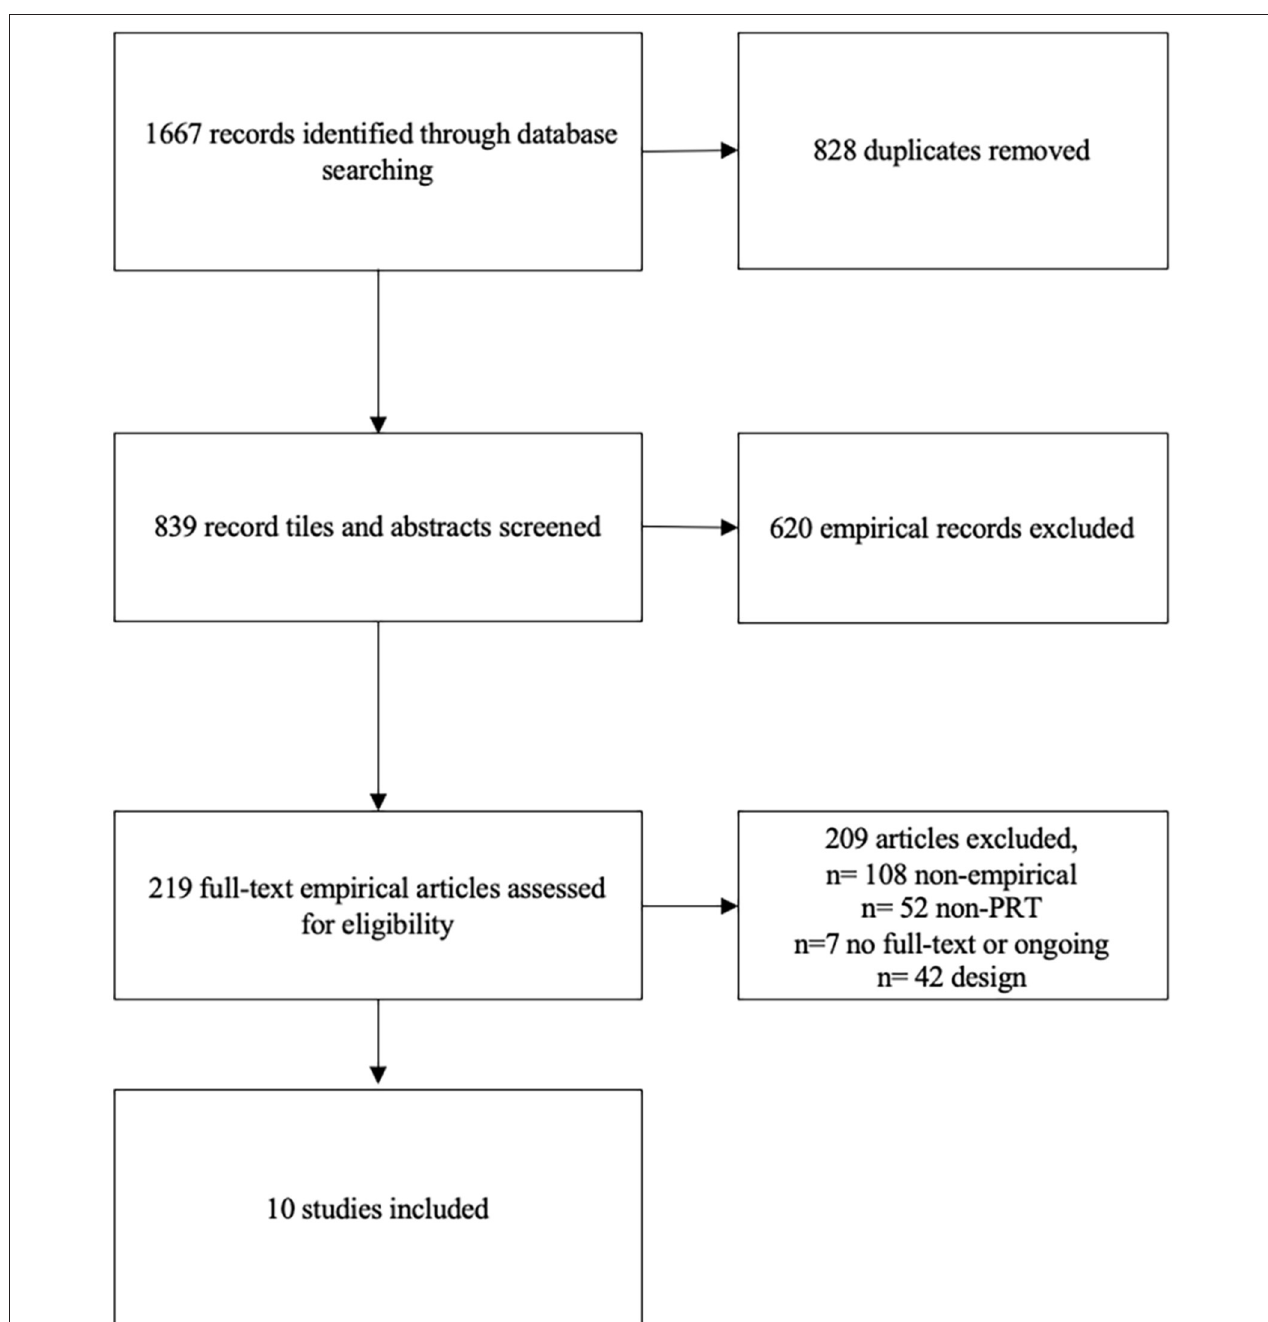
FIGURE 1 | PRISMA flow